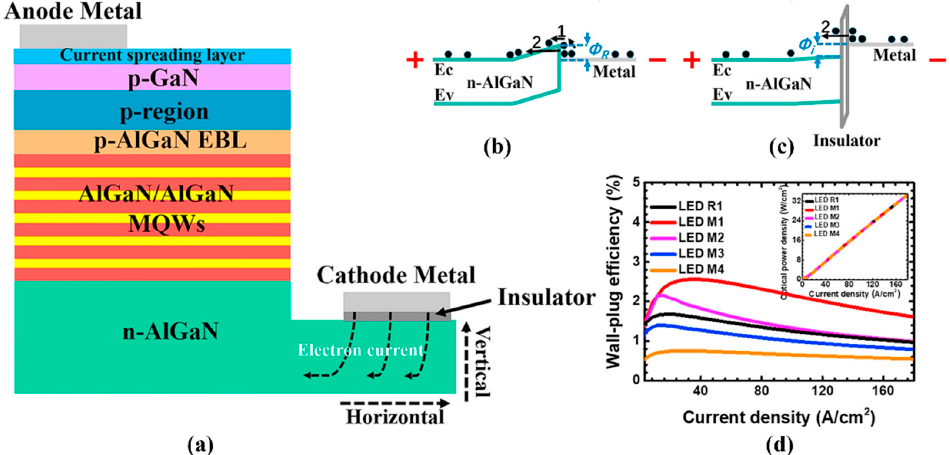
Figure 9. ( a ) Schematic diagram for the proposed MIS-structured DUV LEDs; ( b ) schematic energy band diagram of the n-type metal/semiconductor contact for reference LED; ( c ) schematic energy band diagrams of the MIS structure for the proposed DUV LEDs and ( d ) WPE in terms of the injection current density for LEDs M1–M4 and R1. Inset in ( d ) shows the optical power density in terms of the injection current density for LEDs M1–M4 and R1. Processes 1 and 2 denote the electron transport processes of thermionic emission and intraband tunneling, respectively. E C and E V represent the conduction band and the valence band, respectively. Φ R and Φ i stand for the barrier height for reference LED and different MIS-structured LEDs, respectively. Reproduced from Ref. [113] with permission from Elsevier.